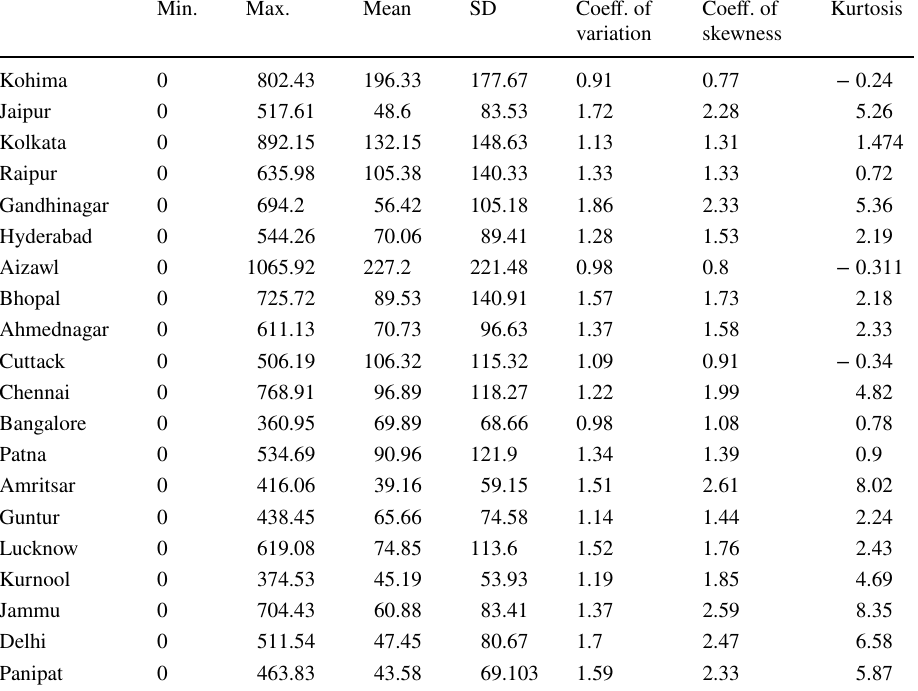
Table 2 Summary statistics of monthly precipitate data for the selected stations during the years (1901–2002). We note that all units of dimensional quantities are in mm